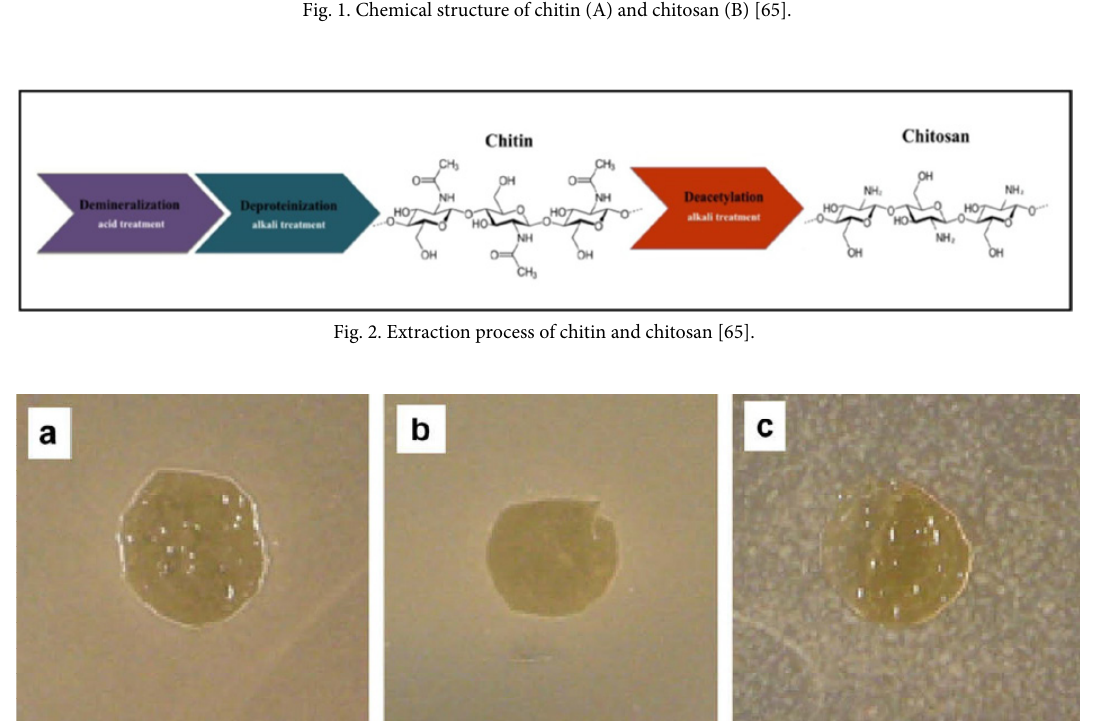
Fig. 3. Inhibitory effect of chitosan film against (a) E. coli , (b) S. aureus , and (c) B. Subtilis [5].